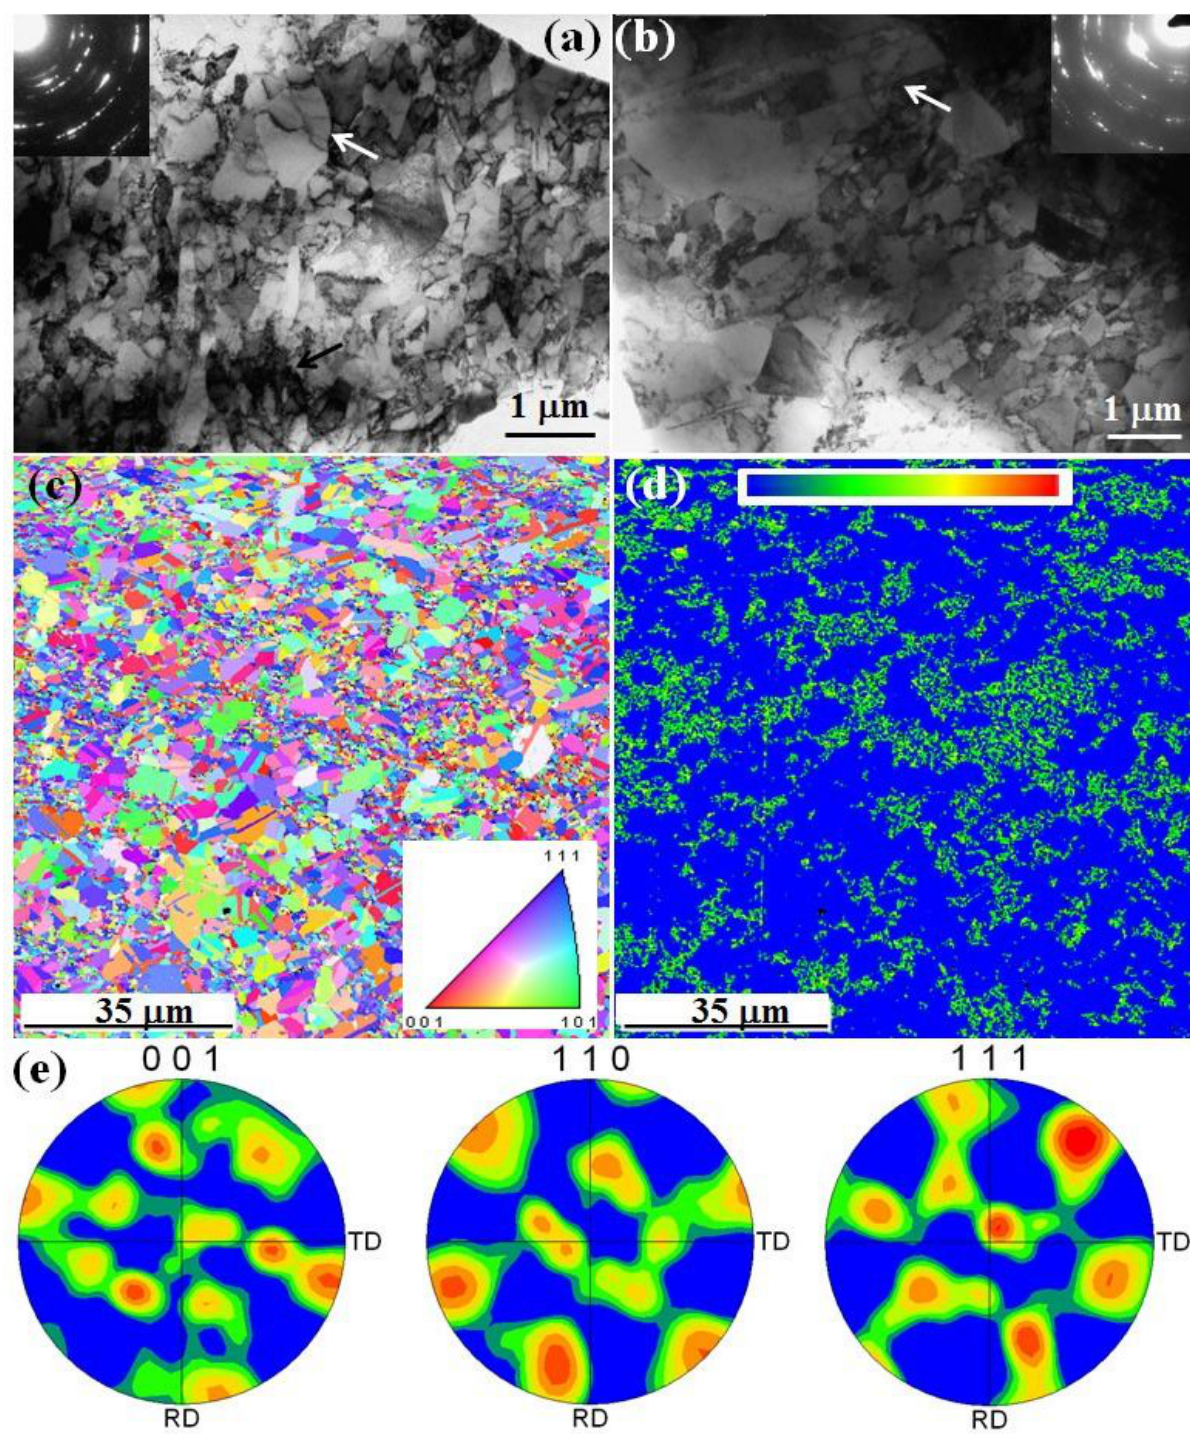
Figure 1: (a) Bright-field TEM image of the as-ECAPed UFG Cu. The inset is the corresponding selected area electron diffraction (SAED) pat- terns taken from an area with a diameter of 5.4 µ m. (b) Bright-field TEM image of the annealed bimodal Cu. The inset is the corresponding SAED patterns taken from an area with a diameter of 5.4 µ m. (c) EBSD orientation mapping of the bimodal Cu, the inset is IPF-Z coloring code; (d) the local average misorientation map of Figure 1(c), inset rainbow bar is the reference code of color-misorientation, in which blue, green and red colors represent low ( < 1 ∘ ), medium (from 1 ∘ to 3 ∘ ) and high (from 3 ∘ to 5 ∘ ) misorientation; (e) the pole figures of Figure